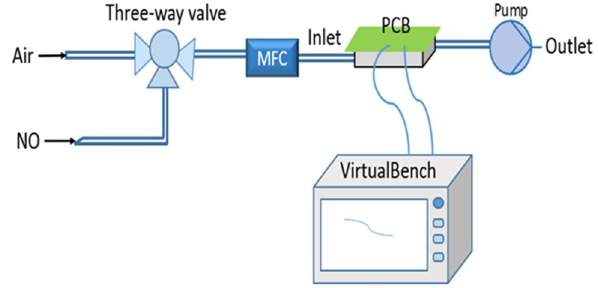
Figure 8. Gas sensing test